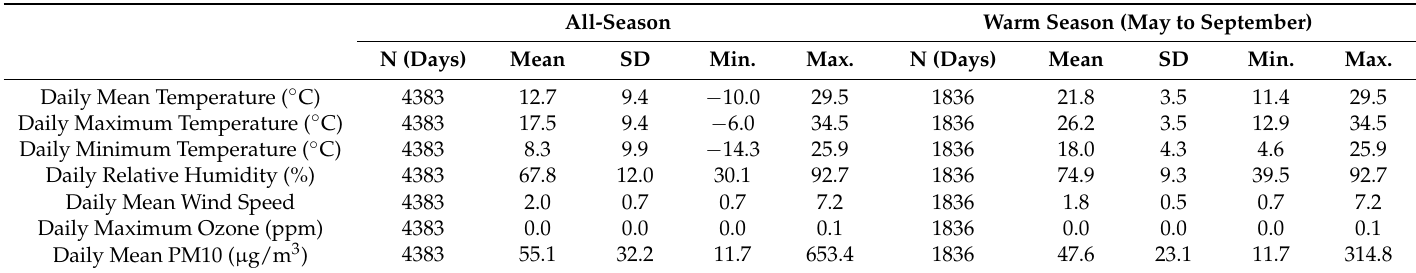
Table 3. Descriptive statistics of meteorological variables and air pollutants from 2002 to 2013 in